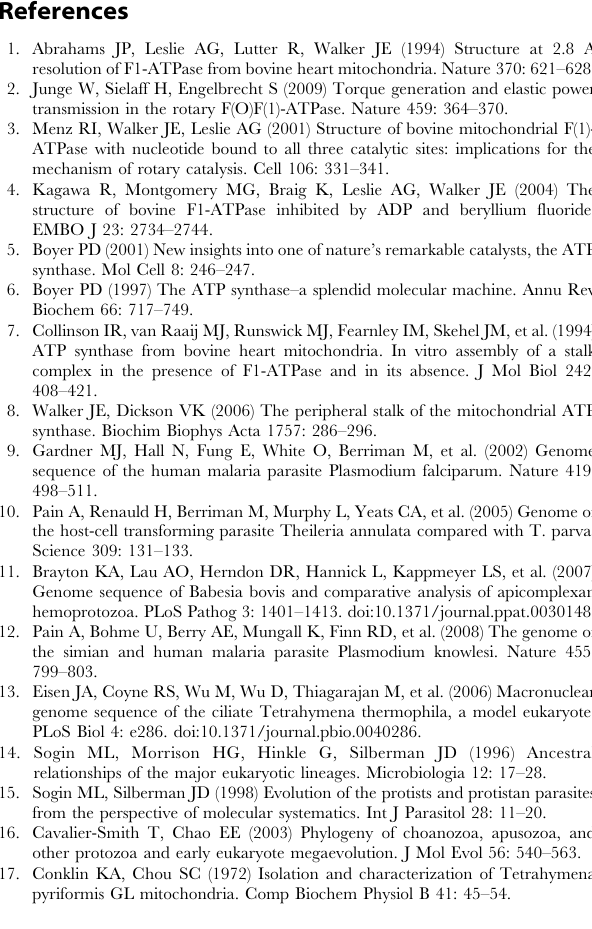
Tabe S1 Summary of proteins identified by mass spectrometric analysis of peptides in bands excised from BN-PAGE gels and spots excised from 2-D BN- PAGE gels. Table S2 Sequences, MS parameters, and deduced parent proteins of peptides identified by LC/MS/MS analysis of bands excised from BN-PAGE gels. Table S3 Sequences, MS parameters, and deduced parent proteins of peptides identified by LC/MS/MS analysis of spots excised from 2-D BN-PAGE gels. Table S4 T. thermophila mitochondrial proteins iden- tified in spots 1–5 excised from 2-D BN-PAGE. The peptides detected by LC/MS/MS (Tables S1–S3) belonging to each of the 60 proteins detected are highlighted within their amino acid sequences.